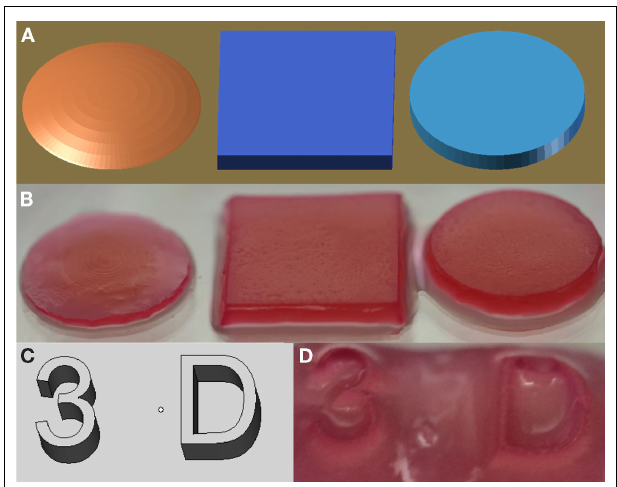
FIGURE 1 | mPDLLA-PEG constructs generated using VL-PSL . (A,B) PDLLA-PEG hydrogels with spherical, cuboidal, and cylindrical architecture (B) based on CAD models (A) . (C,D) Alphanumeric mPDLLA-PEG hydrogels (D) based on CAD models (C) . Formulation used includes mPDLLA-PEG (30% w/v), mHA (0.5% w/v), LAP (0.6% w/v), and phenol red (0.025% w/v).